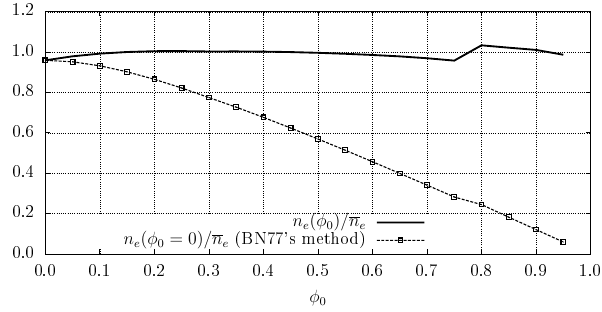
Figure 2. Comparison between the saturated hydraulic conductivity k 0 as estimated by the original BN77 analysis (dotted line and sym- bols) and the method proposed here (solid line) – both normalized by the real value k 0 used to numerically generate the discharge data and varying against the normalized water height at the origin φ 0 .